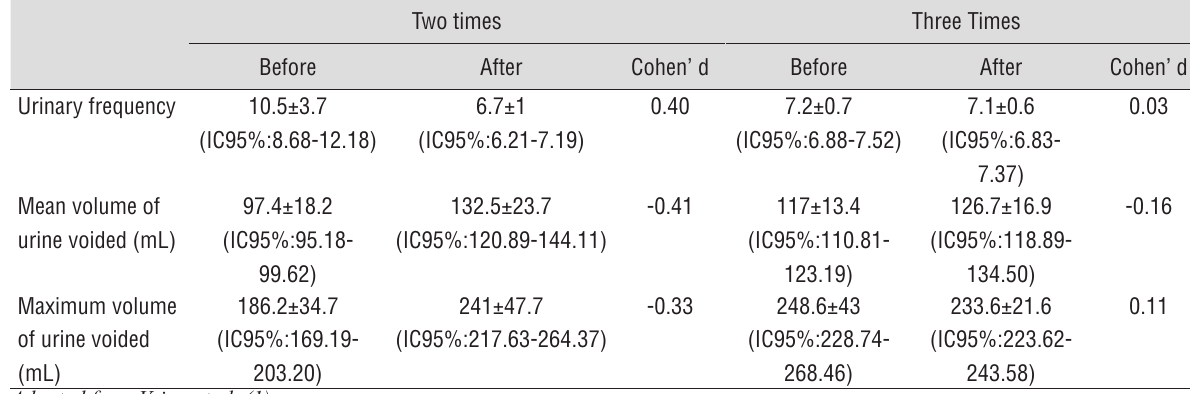
Table 1 - Comparison of the variables of the voiding diary between the groups of two and three times a week of TENS. Two times Three Times Before After Cohen’ d Before After Cohen’